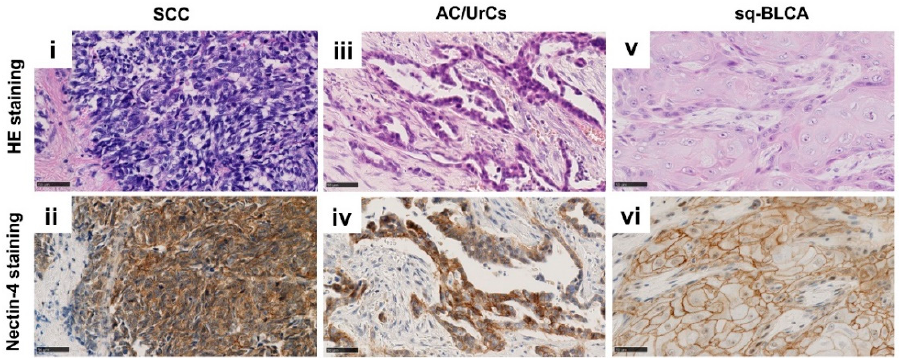
Figure 3. HE and immunohistochemical anti-Nectin-4 staining of SCC ( i , ii ), AC/UrCs ( iii , iv ), and Sq-BLCA ( v , vi ) tissues, respectively. Scale bar: 50 µ m.